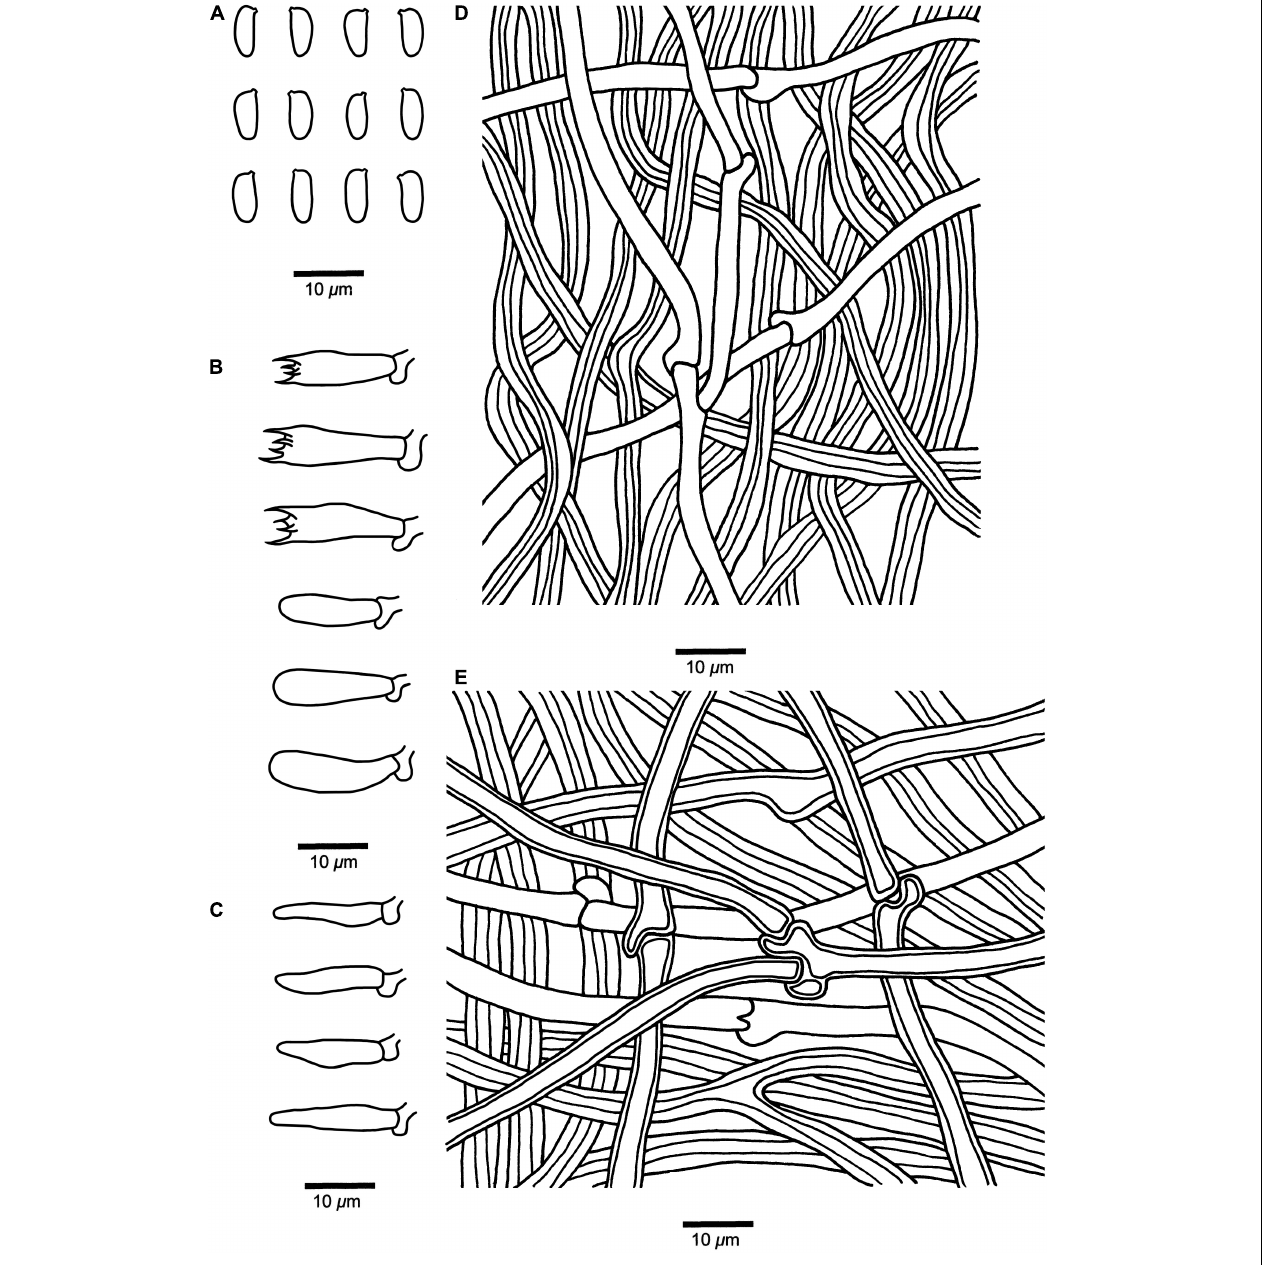
FIGURE 6 | Microscopic structures of Fomitopsis yimengensis (Holotype, Cui 5027 ). (A) Basidiospores. (B) Basidia and basidioles. (C) Cystidioles. (D) Hyphae from trama. (E) Hyphae from context. Drawings by: Shun Liu.